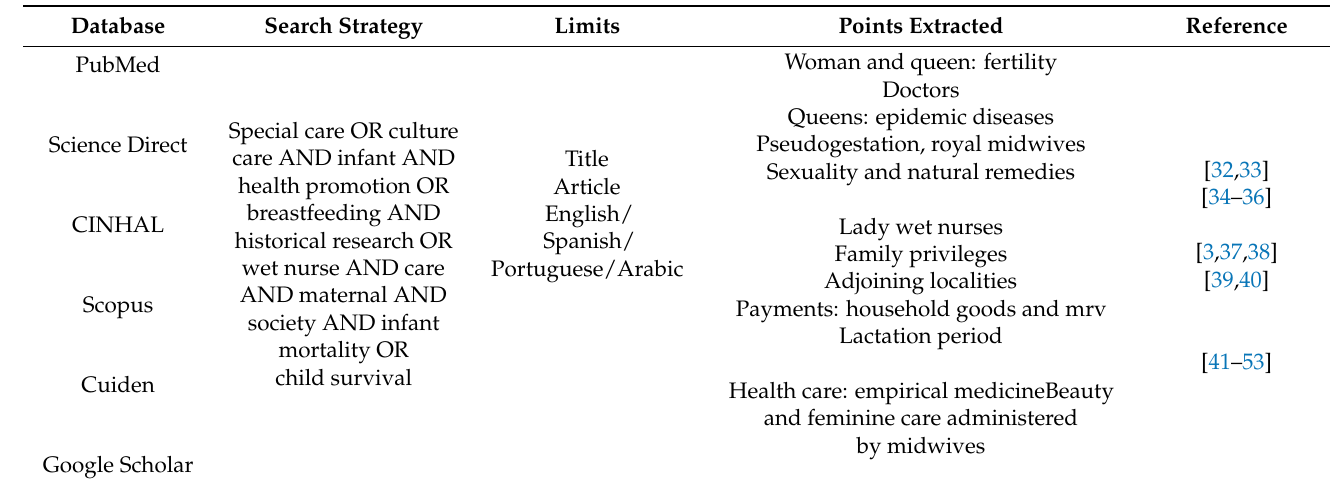
Table 1. Thematic blocks related to the